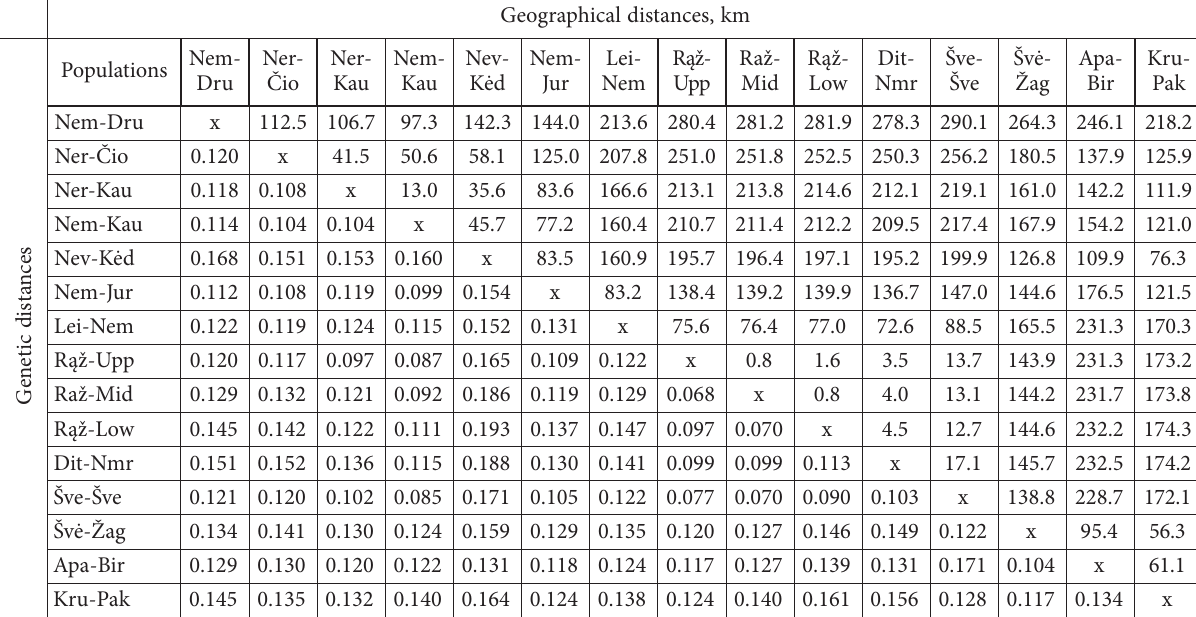
Table 3. AFLP loci based genetic (lower triangle; Nei, 1978) and geographical distances (upper triangle km) between 15 Lithuanian populations of Lythrum salicaria Geographical distances,